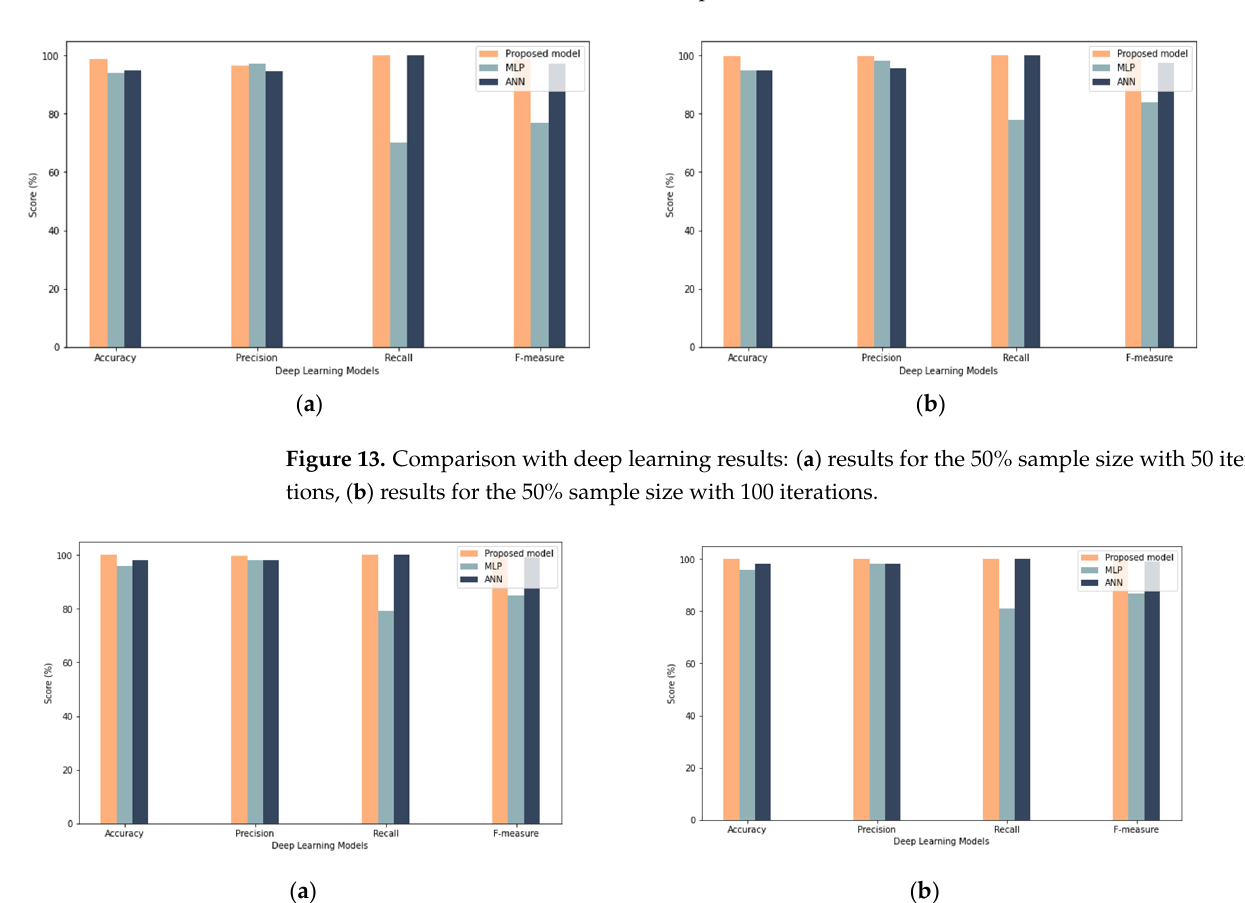
Figure 12. Comparison with Deep Learning Results ( a ) shows results for 25% sample size with 50 iterations ( b ) show results for 25% sample size with 100 iterations.